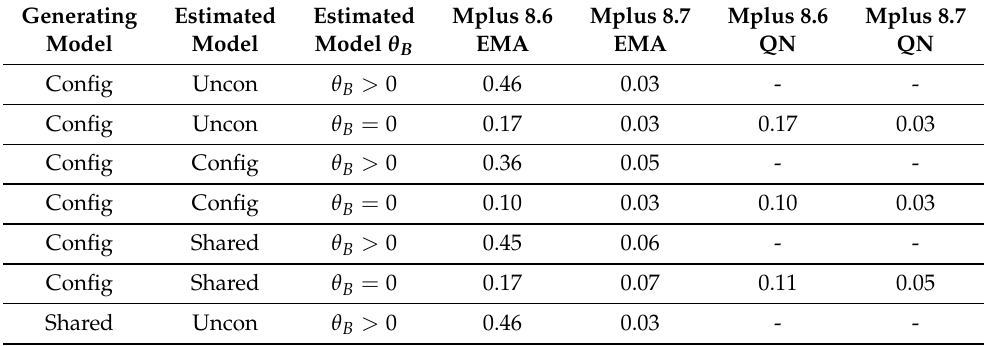
Table 1. Rejection rates of the robust chi-square test of fit corresponding to Table 6, rows 7–12 and 19–24 in Jak et al. [1], θ B = 0 for the generating model.